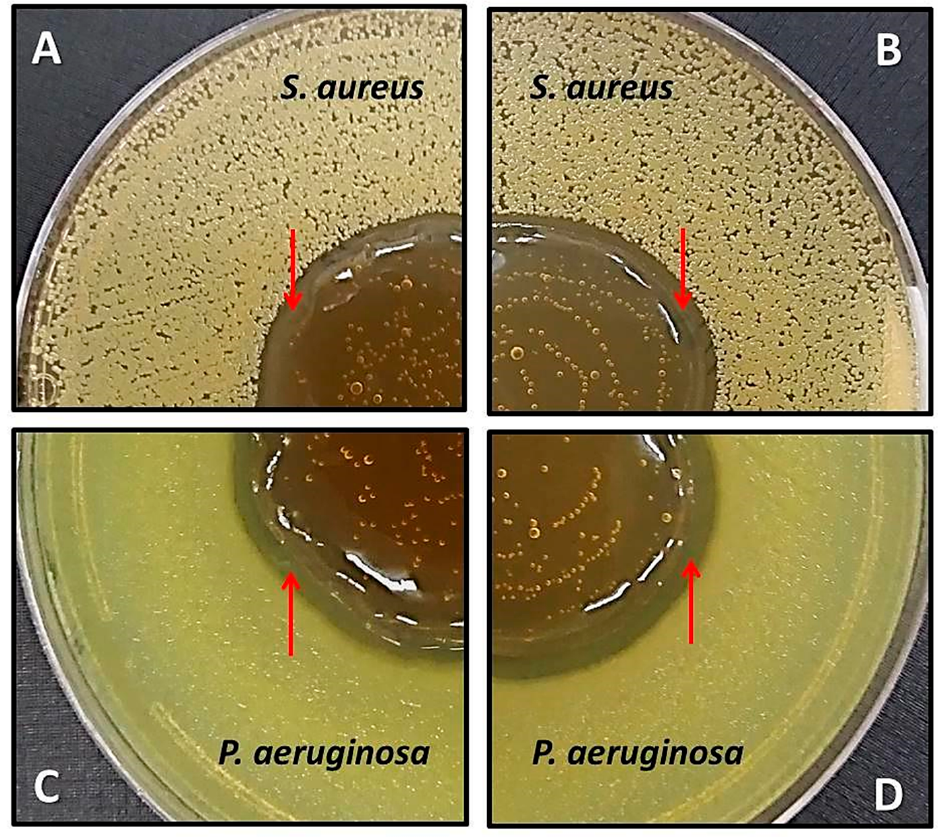
Figure 7. Direct contact antibacterial effect of NCG-AgNPs ( A and C ) and PhCG-AgNPs ( B and D ) hydrogels, with the presence of halos of inhibition indicated by arrows.